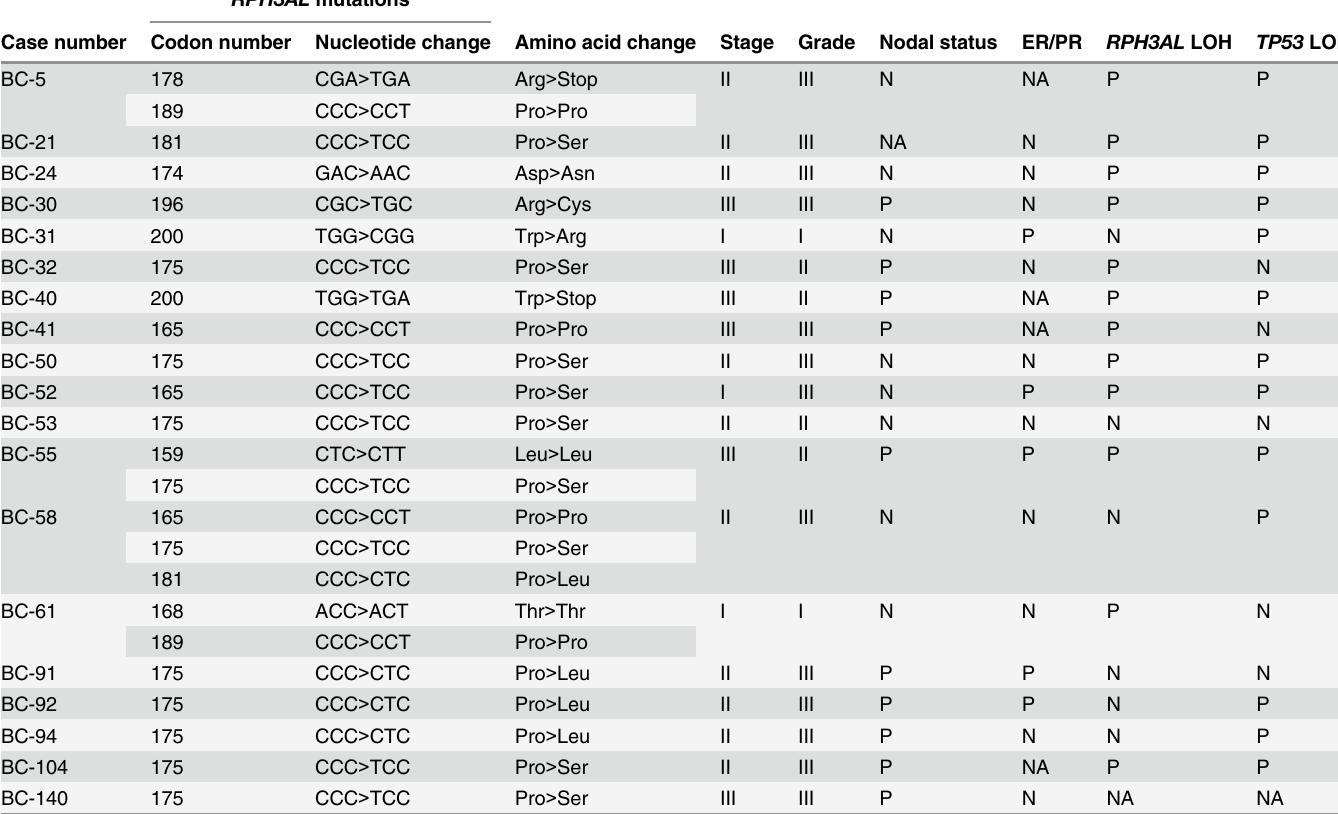
Table 2. Genetic abnormalities of the RPH3AL gene and demographic and pathological features of breast cancers. RPH3AL